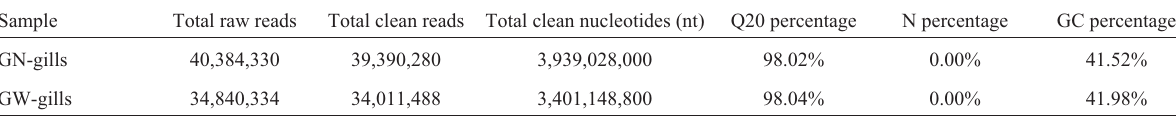
Table 1 - Summary of Illumina sequencing output for the GN and the GW.